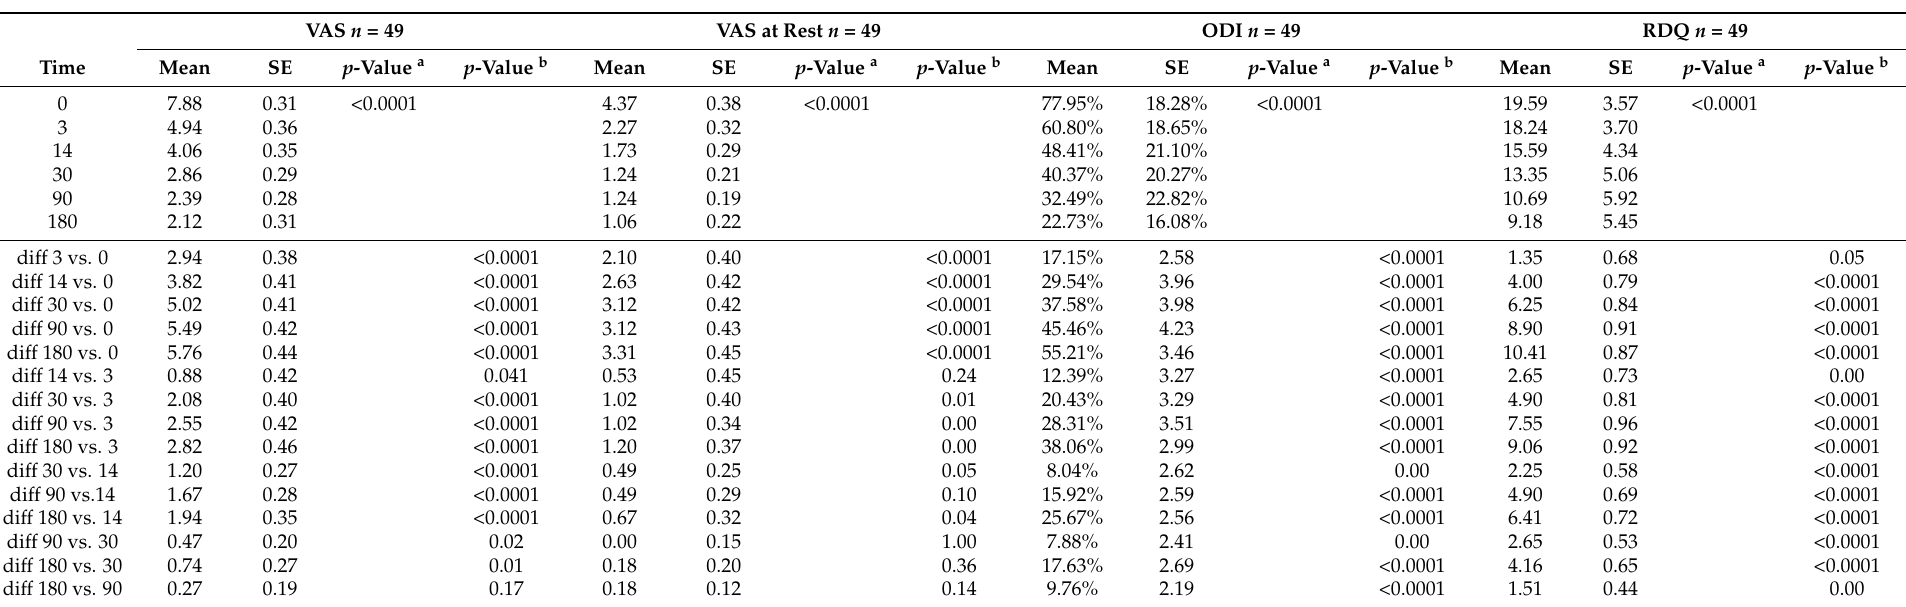
Table 2. Changes in outcome scales over time after the procedure and comparison of outcome scales at each time point after